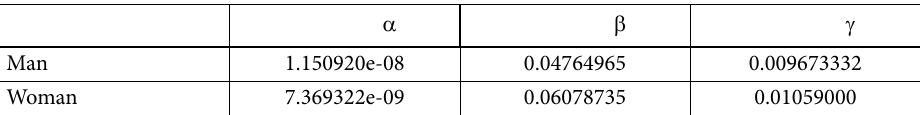
Table 2. Parameters of the prevalence rate (source: own elaboration from Instituto de Mayores y Ser- vicios Sociales, 2019) a